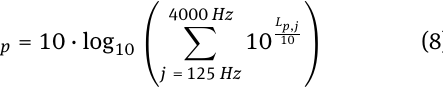
In Figure 2, r W is the distance run by the primary wave- front at time t , r 0 is the distance between the primary wave- front and the receiver, and λ is the